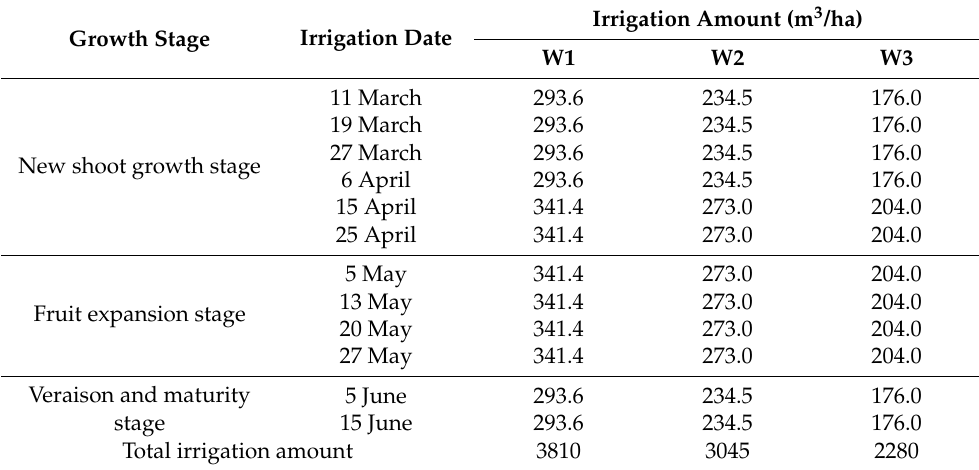
Table 1. Irrigation amount of grapevine at different growth